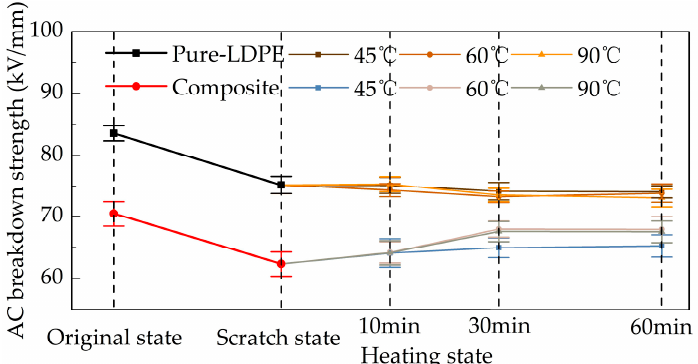
Figure 2. Alternating current (AC) breakdown strength of polyethylene samples.